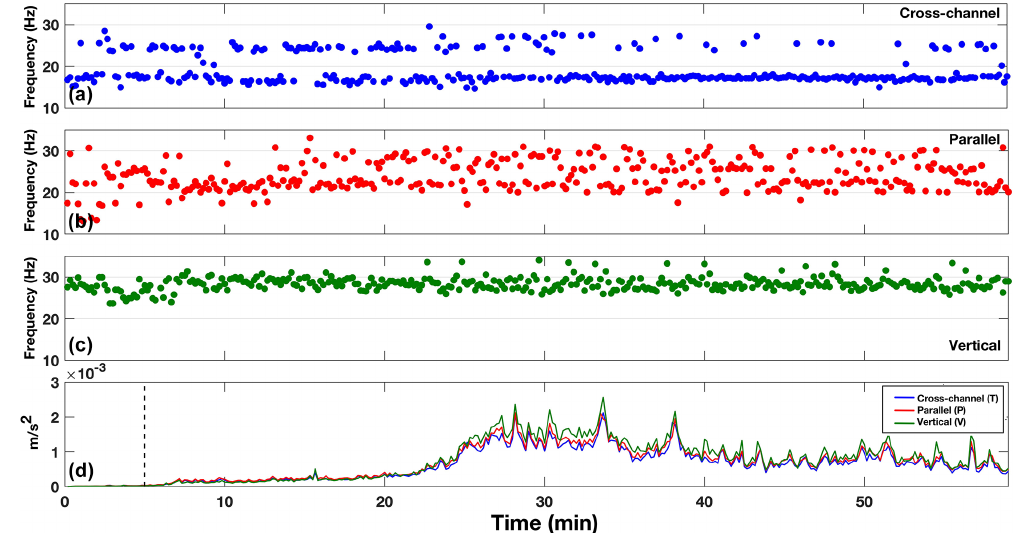
Figure 5. Peak spectral frequencies for COLL (83km from source) for (a) cross-channel (blue), (b) flow-parallel (red), and (c) vertical (green) directions. Bottom row (d) depicts the rms amplitude of the lahar color coded to the same colors as the PSF. The dashed vertical line marks the timing of the lahar front passing the monitoring station. All PSFs and rms amplitudes were calculated using 10s time windows.